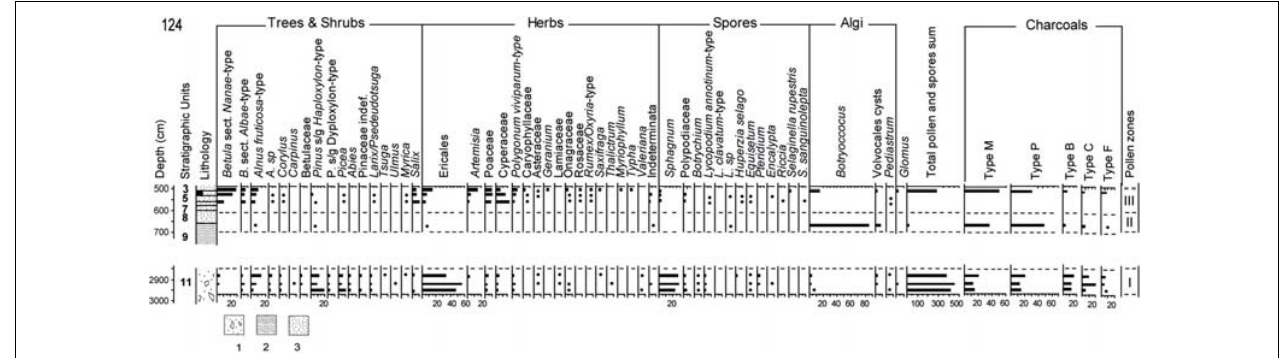
FIGURE 8 | Percentage pollen, spore, and non-pollen-palynomorph and charcoal diagram of site 124 (for location see Figure 1B ). 1 – green–gray pebble bed with sand and fine-sand loam; 2 – slightly consolidated gray–green pebble bed with sand and debris lenses and some wood remains; 3 – fine sand with lenses and layers of plant and woody remains, partly